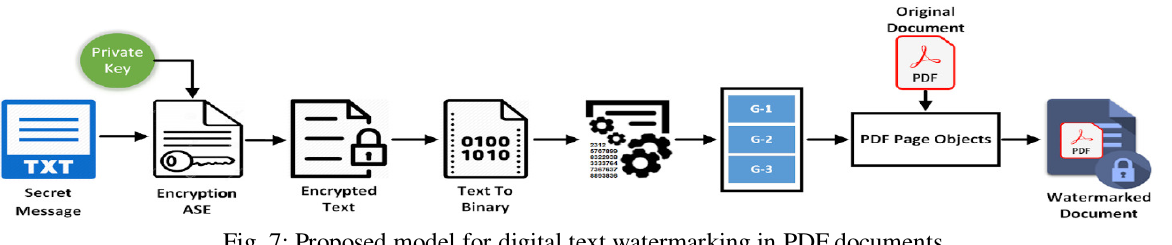
Fig. 7: Proposed model for digital text watermarking in PDF documents